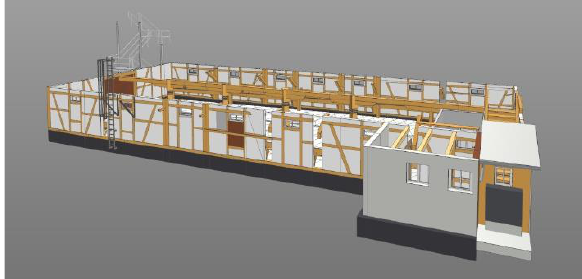
Figure 7 . LOD400 BIM Model of the ground level of Salzmagazin in ArchiCAD